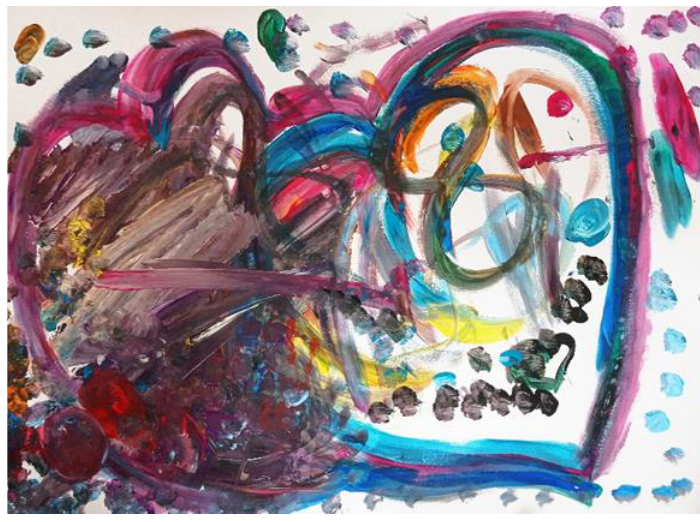
Figure 1. Rona and her mother.